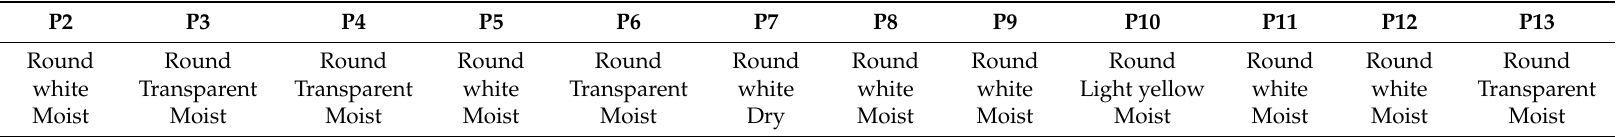
Table 1. Colony characteristics of phosphorus-dissolving bacteria on PVK